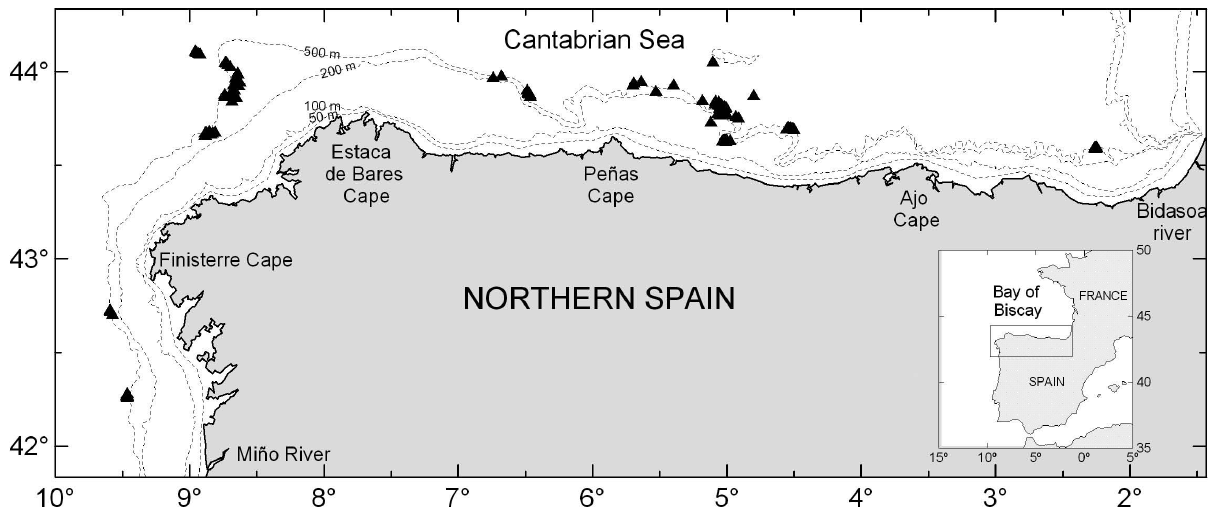
Fig . 1. – Study area. Black triangles represent haul